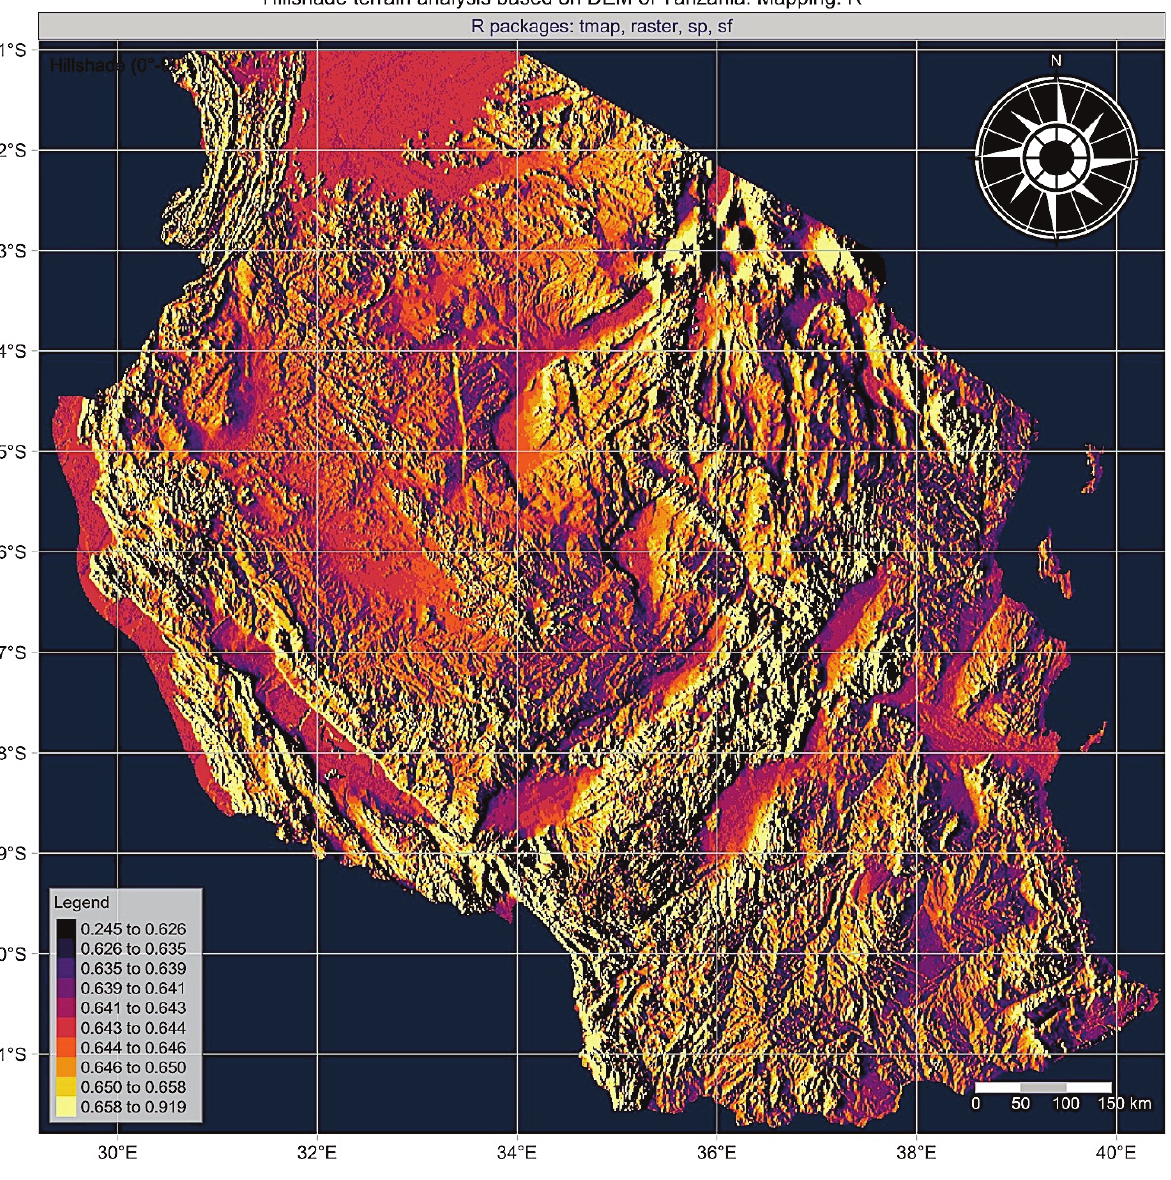
Fig. 8 . Hillshade terrain visualization based on DEM of Tanzania. Mapping by R using packages ‘tmap’, ‘raster’, ‘sp’, ‘sf’. Map source: elaborated by the